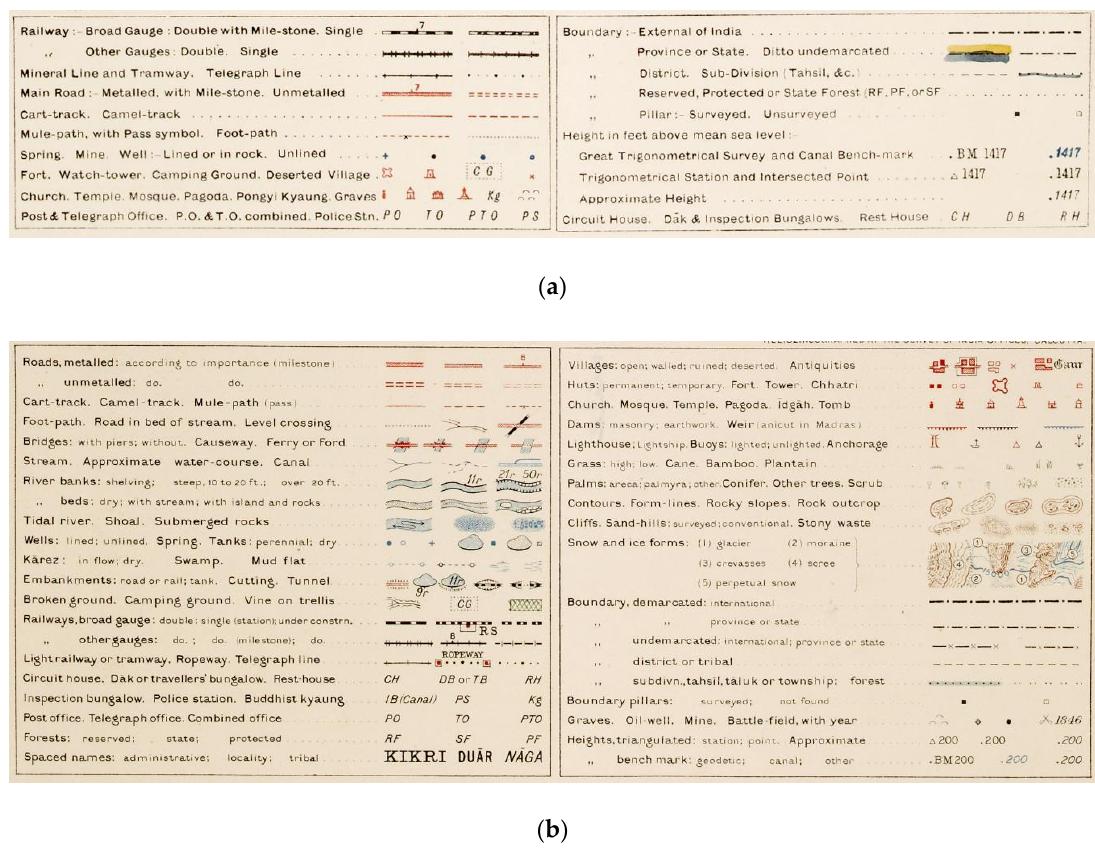
Figure 4. ( a ) Reproduction of legend from a 1915 map (53/C3/1915); ( b ) Reproduction of legend from a 1936 map (53/D9/1936) (Images courtesy of Cambridge University Library).